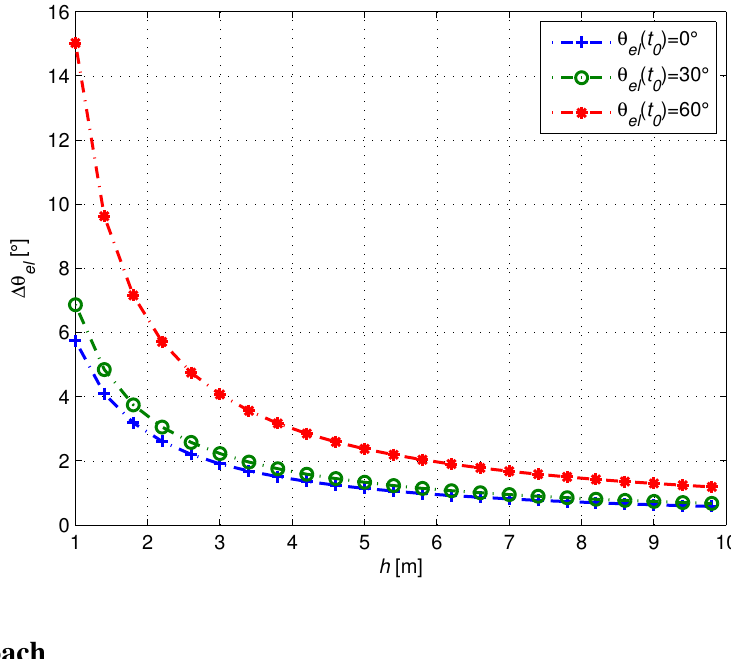
Figure 2. Satellite elevation variation as a function of the antenna